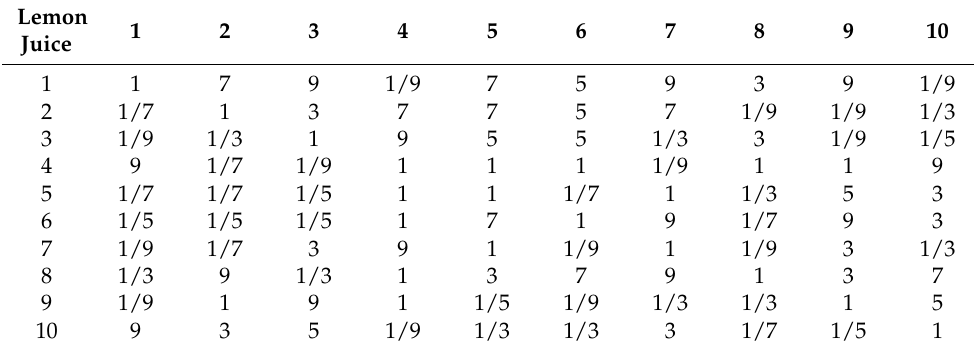
Table A26. Pairwise comparisons matrix of lemon juice.